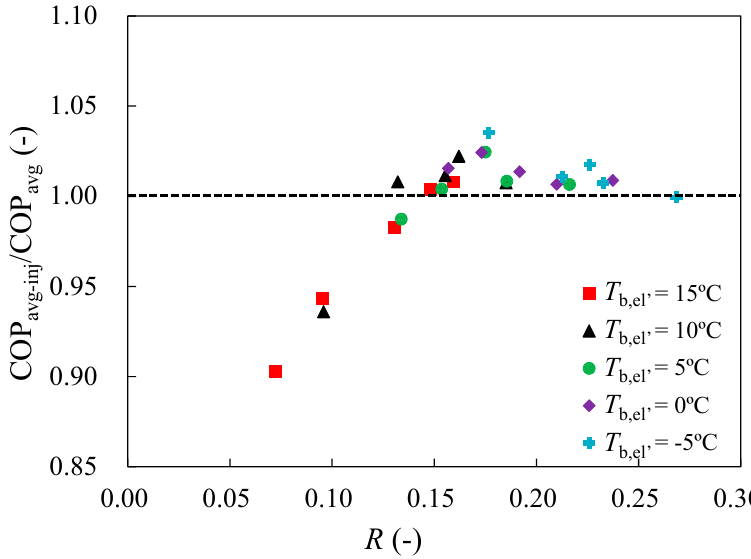
Figure 12. The variation of normalized heating COP avg-inj / COP avg with injection ratio R of the vapor injection heat pump cycle.